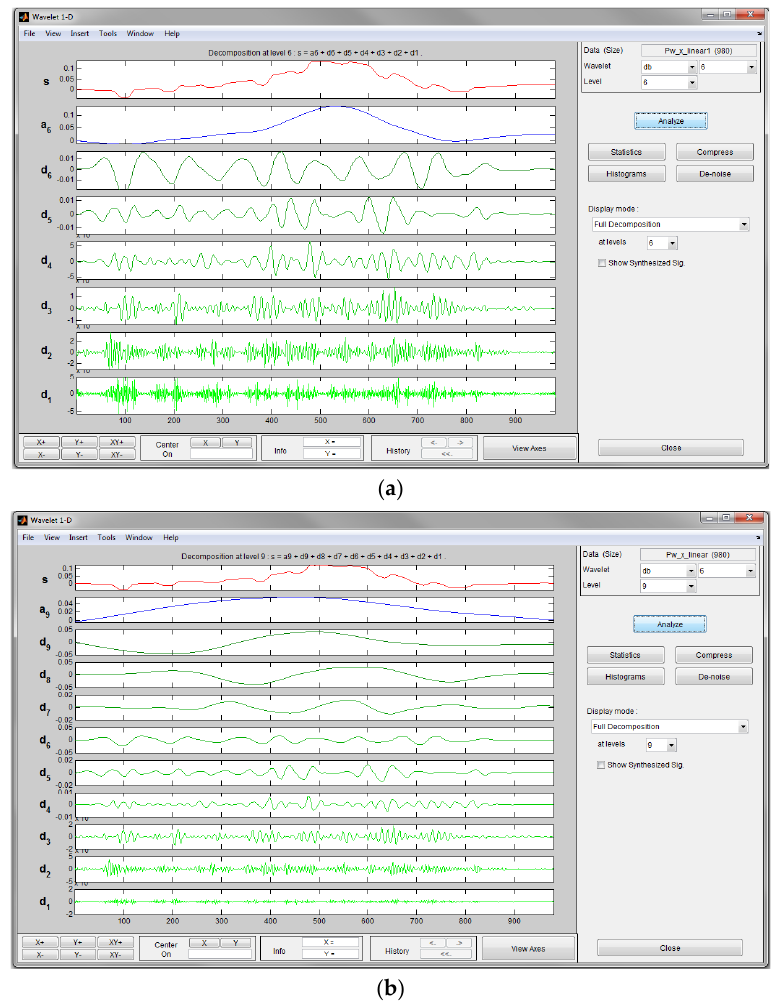
Figure 10. Wavelet analysis decomposition level. ( a ) Wavelet ‘db6’ level 6. ( b ) Wavelet ‘db6’ level 9.